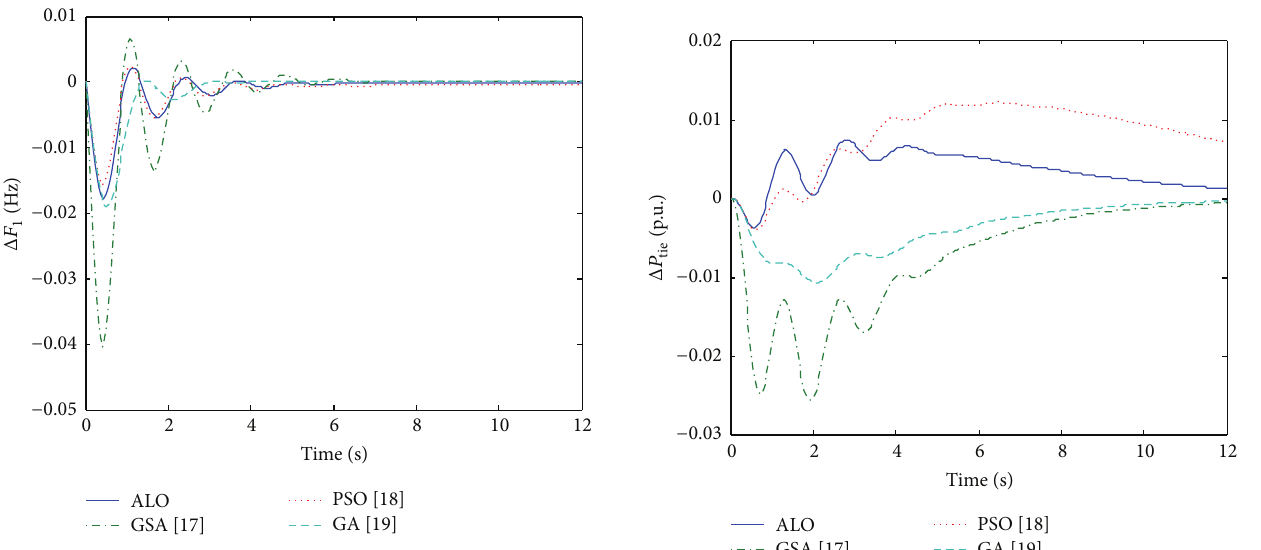
Figure 14: Change in frequency of area 1 by 25% load decreases in area 1.